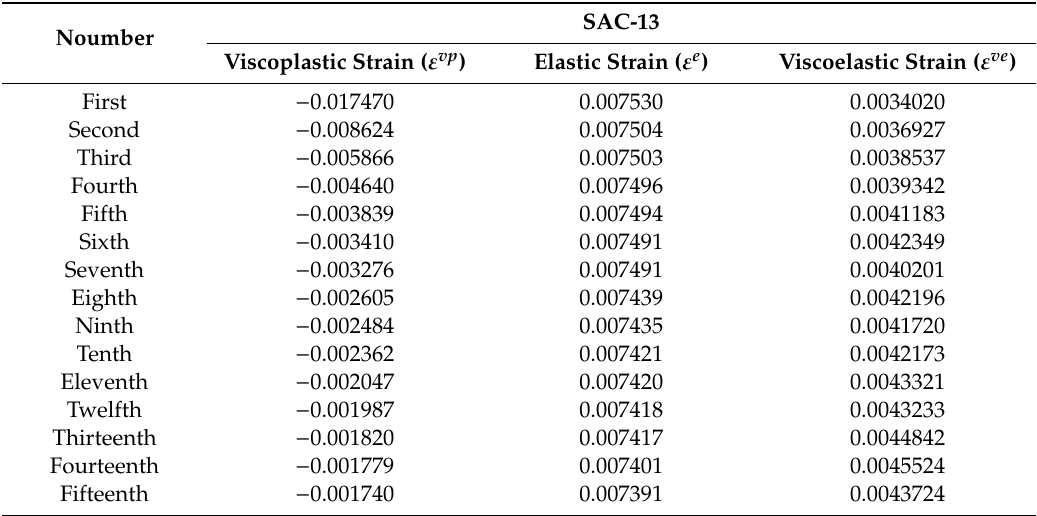
Table 5. Viscoelastic-plastic strain of AC-13 and SAC-13 asphalt mixture.